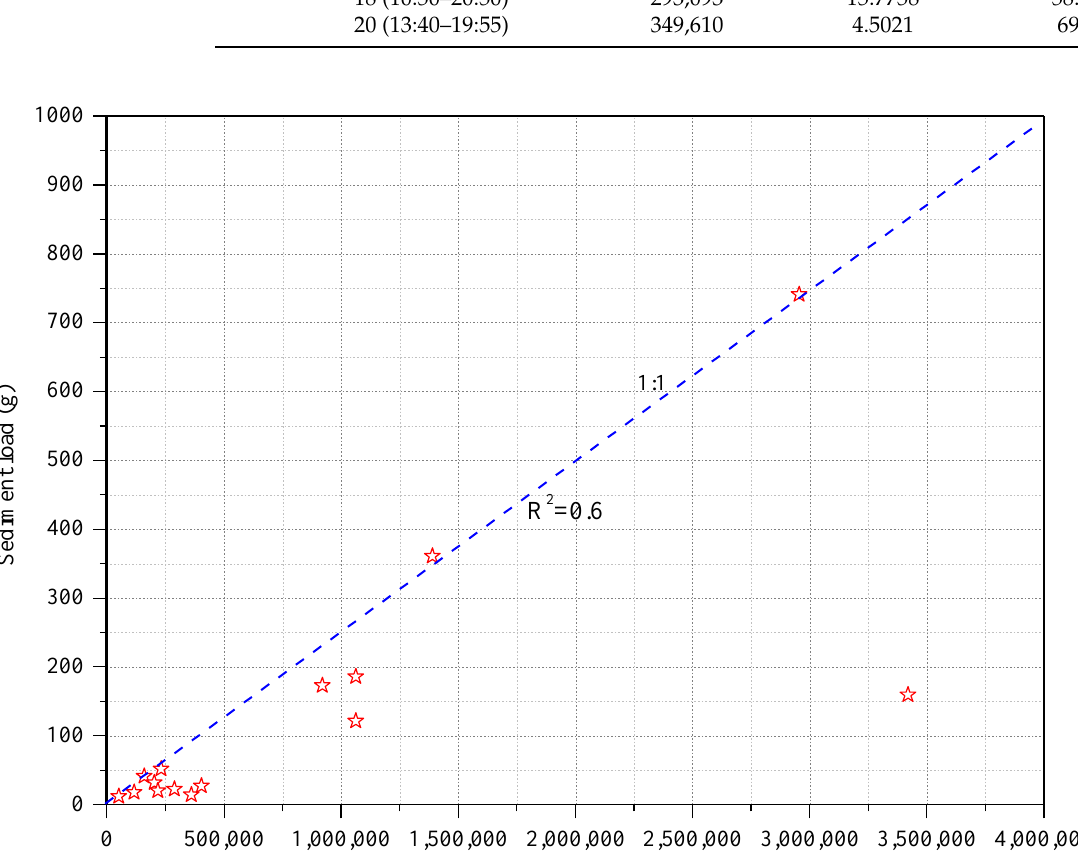
Figure 6. Change of sand collection quantity with saltation particle numbers. As shown in Figure 7, the theoretical and observed sand masses were fitted and ana- lyzed, and the two did not show any linear relationship, with a R 2 of only 0.40, indicating the large difference between the observed and theoretical values. The reason for this large discrepancy was that the theoretical values were calculated based on the actual amounts of collected sand and the number of sand particles impacting the sensor. In addition, the